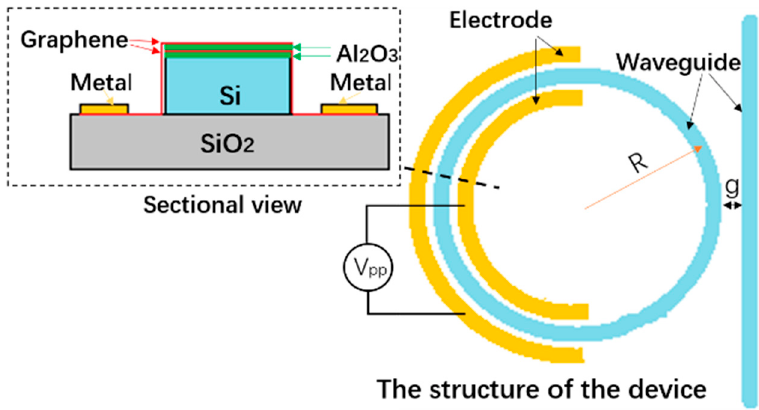
Figure 2. The layout of the graphene–assisted optical ring modulator.